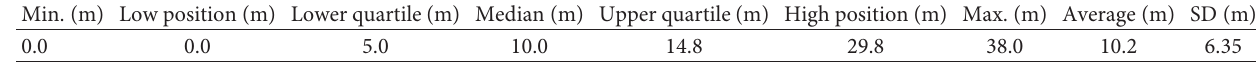
Table 6: Statistics of the soft soil thickness.